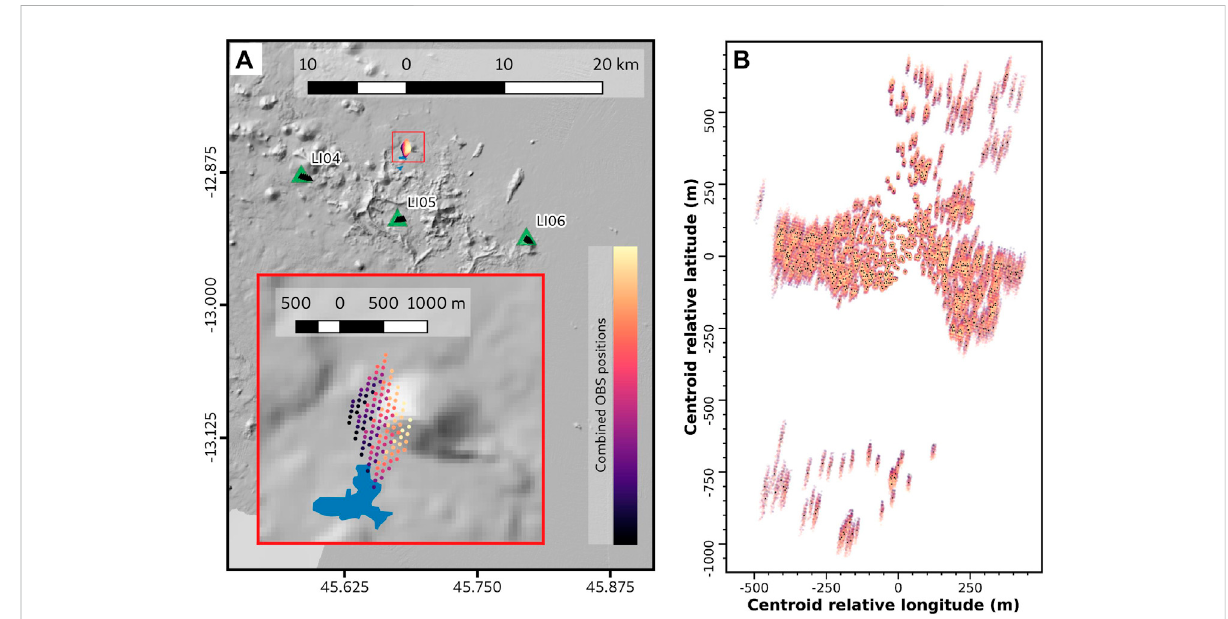
FIGURE 3 (A) :Centroid of the source locations computed with each of the 125 OBS network con fi gurations (represented with the color scale). The green triangles represent the deployment locations of the three stations we used. The black triangles on top represent the station location variations we tested. The insert shows a zoom on the events locations (red square). The blue patch corresponds to the area of reliable depth changes deduced from MBES surveys over the whole survey. (B) : Events locations (color dots for each event) relative to the centroid point for all the network con fi gurations. The color scale indicate the set of OBS positions